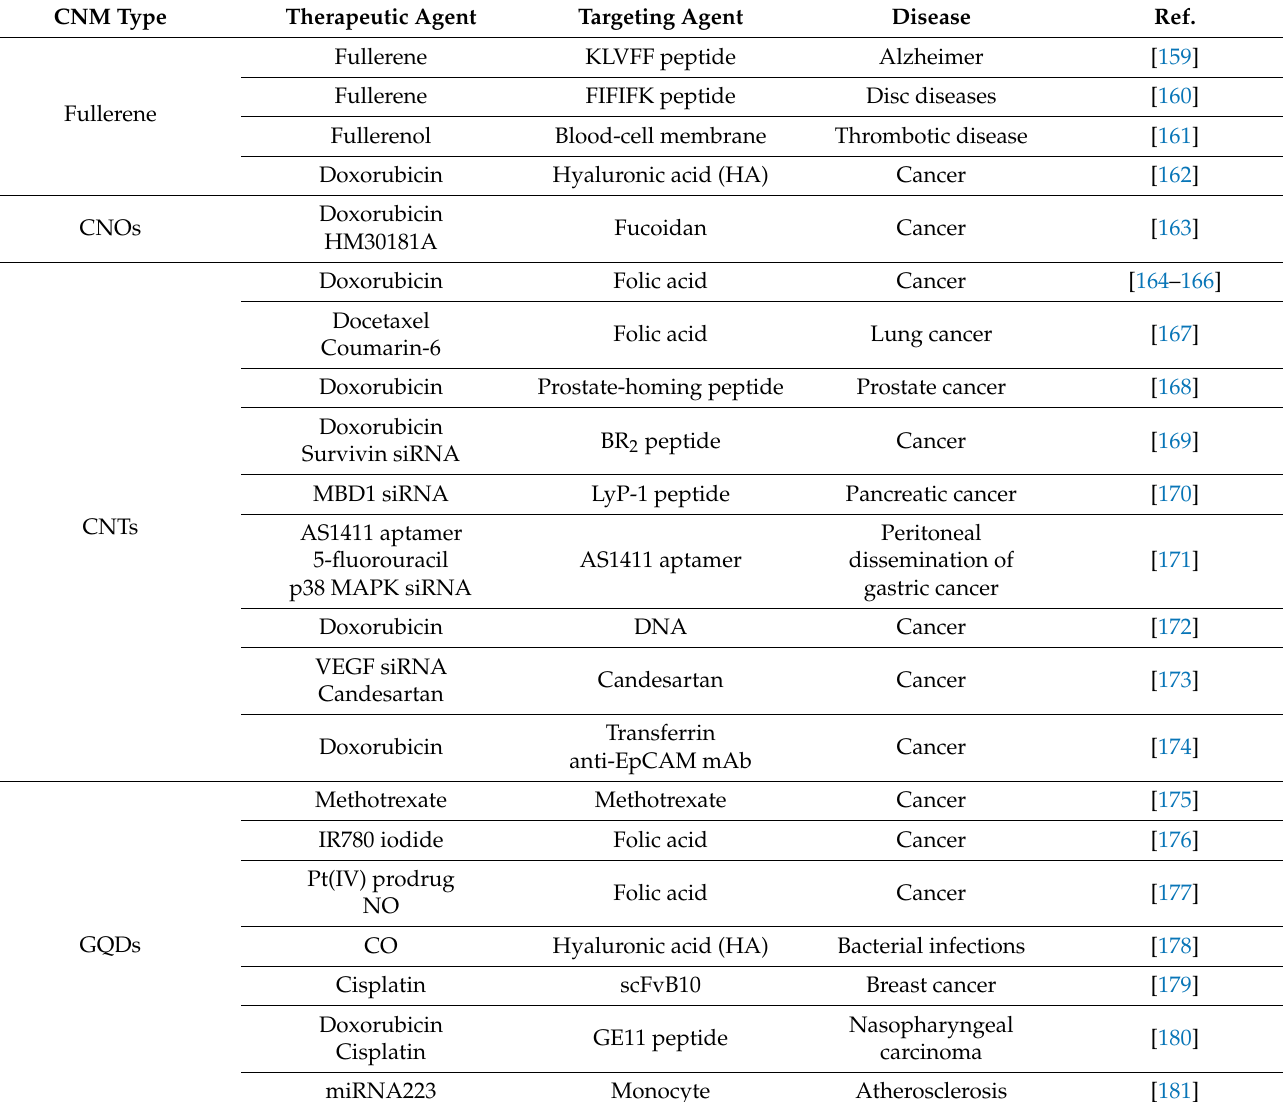
Table 4. Recent examples of the use of CNMs in molecular-targeted drug delivery.